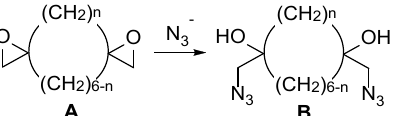
Figure 1. Examples of marketed drugs and bioactive compounds containing oxirane or cyclooctane rings.